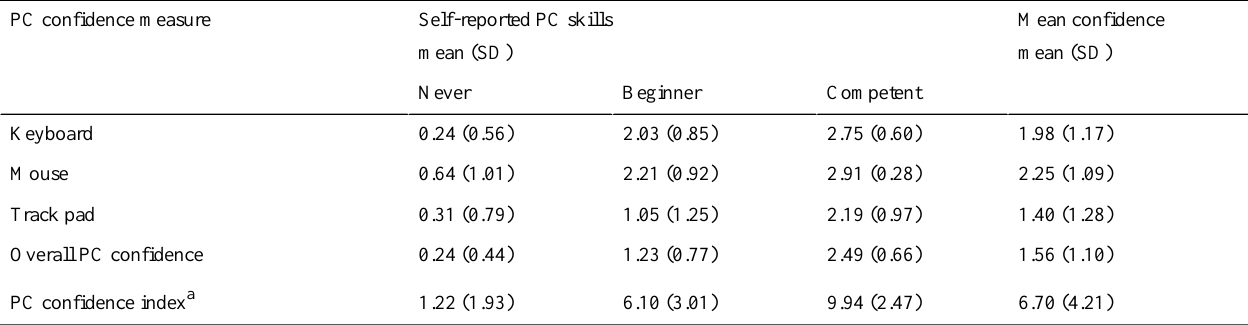
Table 1. Mean PC confidence scores (range 0-3; 0=not at all confident to 3=confident) and PC confidence index (range 0-12) by PC skill level for computer confidence questionnaire respondents (n=84).